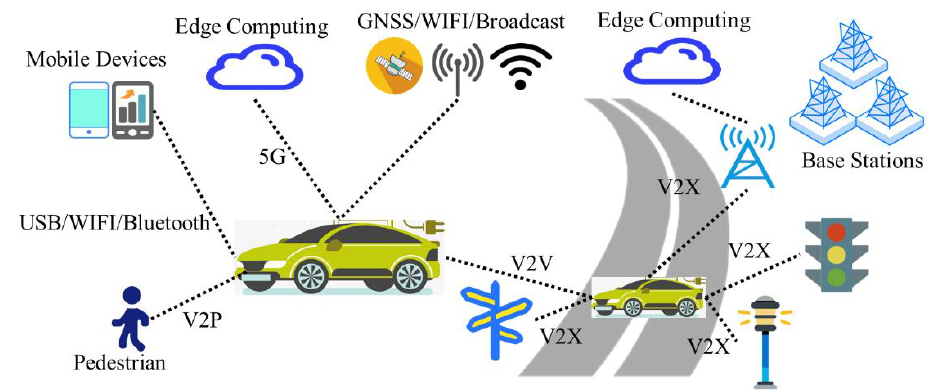
Figure 4. Vehicle network communication architecture.